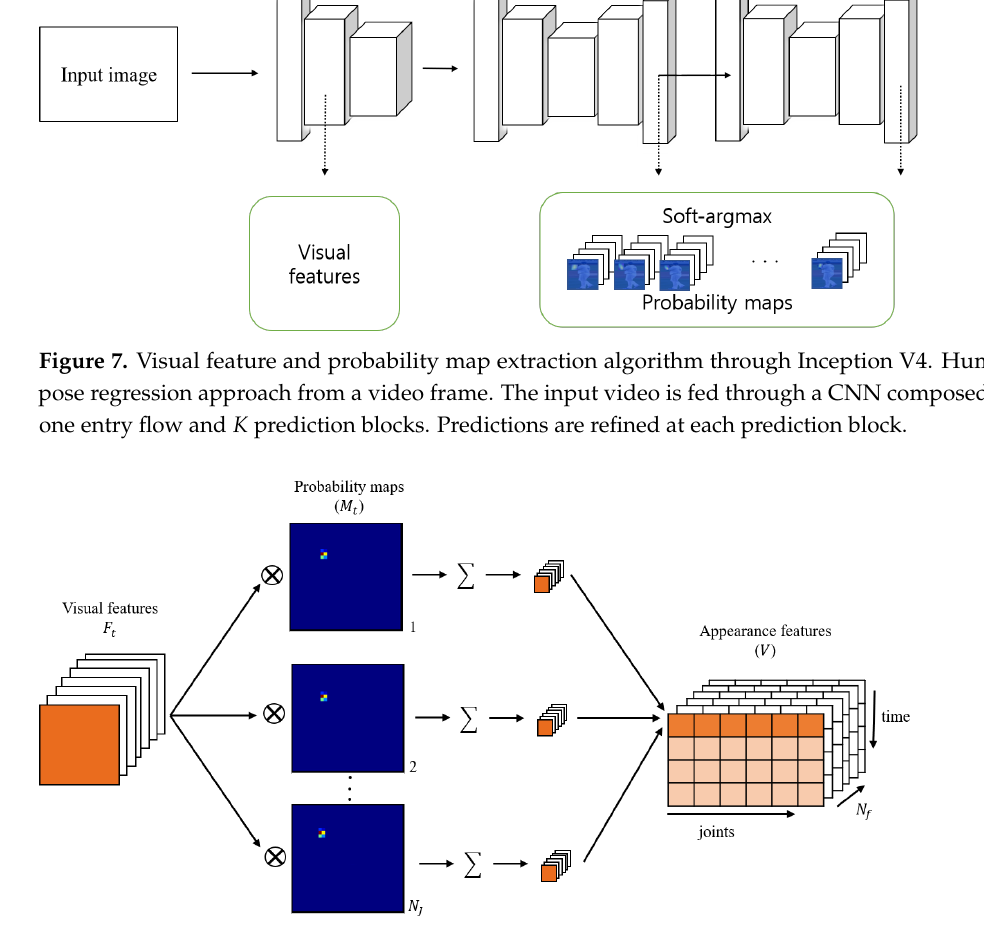
Figure 8. Appearance based activity recognition. Appearance features extraction from low level visual features and body parts probability maps for a single frame. For a sequence of T frames, the appearance features are stacked vertically producing a tensor where each line corresponds to one input